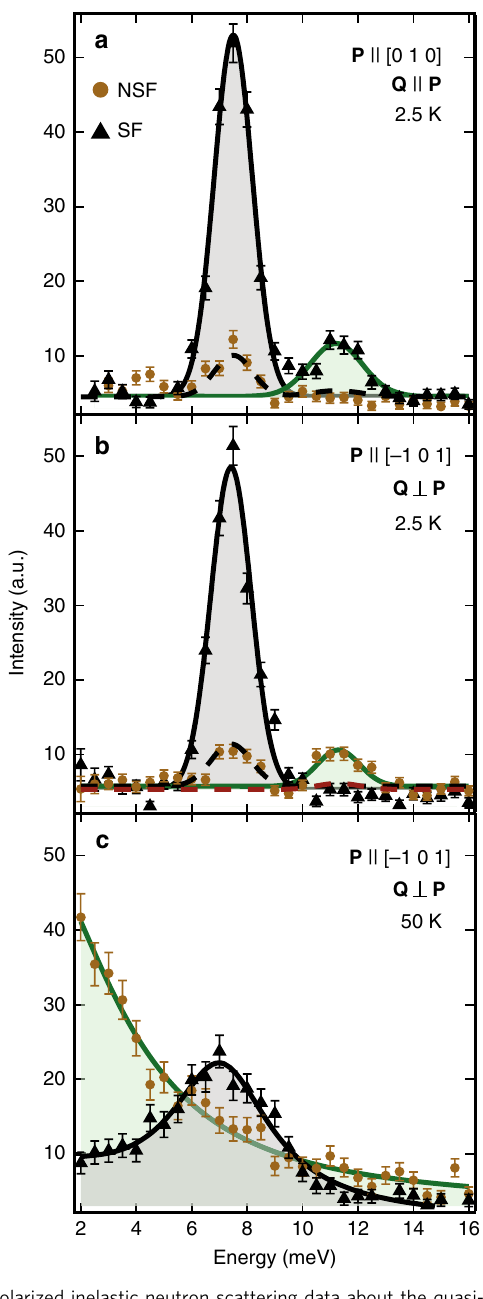
Fig. 4 Polarized inelastic neutron scattering data about the quasi-1D zone center Q = (0, 1.5, 0). a Data collected with the neutron polarization P parallel to Q . The two modes appear only in the spin- fl ip (SF) channel and so are both magnetic in origin. b Data collected with the neutron polarization P parallel to the [ − 1, 0, 1] axis. Transverse spin fl uctuations appear in the SF channel, and longitudinal fl uctuations appear in the non spin- fl ip (NSF) channel. Data in both a and b were taken in the 3D ordered state at T = 2.5 K, and black dashed lines indicate the expected bleed through from the SF channel into the NSF channel due to imperfect neutron polarization. The red dashed line in b represents the expected bleed through from the NSF channel into the SF channel. c The same con fi guration as b but above the antiferromagnetic transition temperature at T = 50 K. Solid lines in a and b are Gaussian fi ts parameterizing each mode. The solid line for the NSF channel in c is a Lorentzian fi t centered at Δ E = 0 meV and the solid line for the SF channel in c consists of two Lorentzian fi ts (one centered at Δ E = 0 meV and one at the single magnon gap energy). Error bars represent one standard